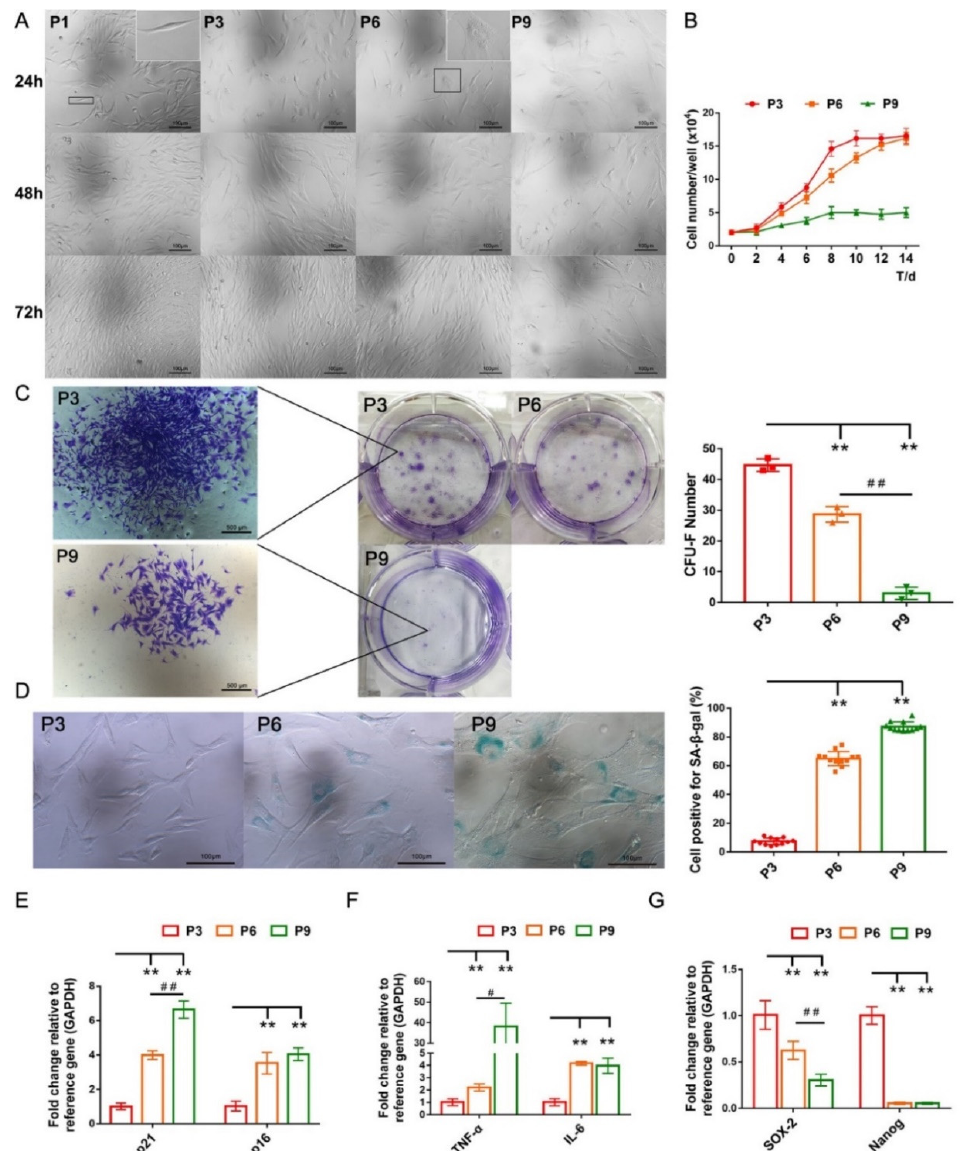
Figure 2. Senescence characteristics of cBMSCs after expansion in vitro. ( A ) Cell morphology of cBMSCs (P1, P3, P6, and P9) cultured in vitro for 24 h, 48 h, and 72 h; scale bars = 100 μ m. ( B ) Growth curve of cBMSCs (P3, P6, and P9) was determined by cell counting. The proliferation capacity of cBMSCs was gradually decreased over the process of long-term cultivation and they underwent growth arrest at P9. ( C ) CFU-F assays of cBMSCs at P3, P6, and P9. The number of colonies was estimated after culturing in vitro for 14 d. ( D ) Representative image of SA- β -gal staining and percentage of SA- β -gal positive cells in cBMSCs at P3, P6, and P9. The expression of senescence-related genes of p21 and p16 ( E ), pro-inflammatory cytokine genes TNF- α and IL-6 ( F ), and stemness markers Nanog and SOX-2 ( G ) measured by RT-qPCR. Gene expression was normalized relative to the expression of GAPDH . These values are the mean ± SD of triplicate experiments. ** p < 0.01 compared with P3. # p < 0.05, ## p < 0.01 for intragroup comparisons.